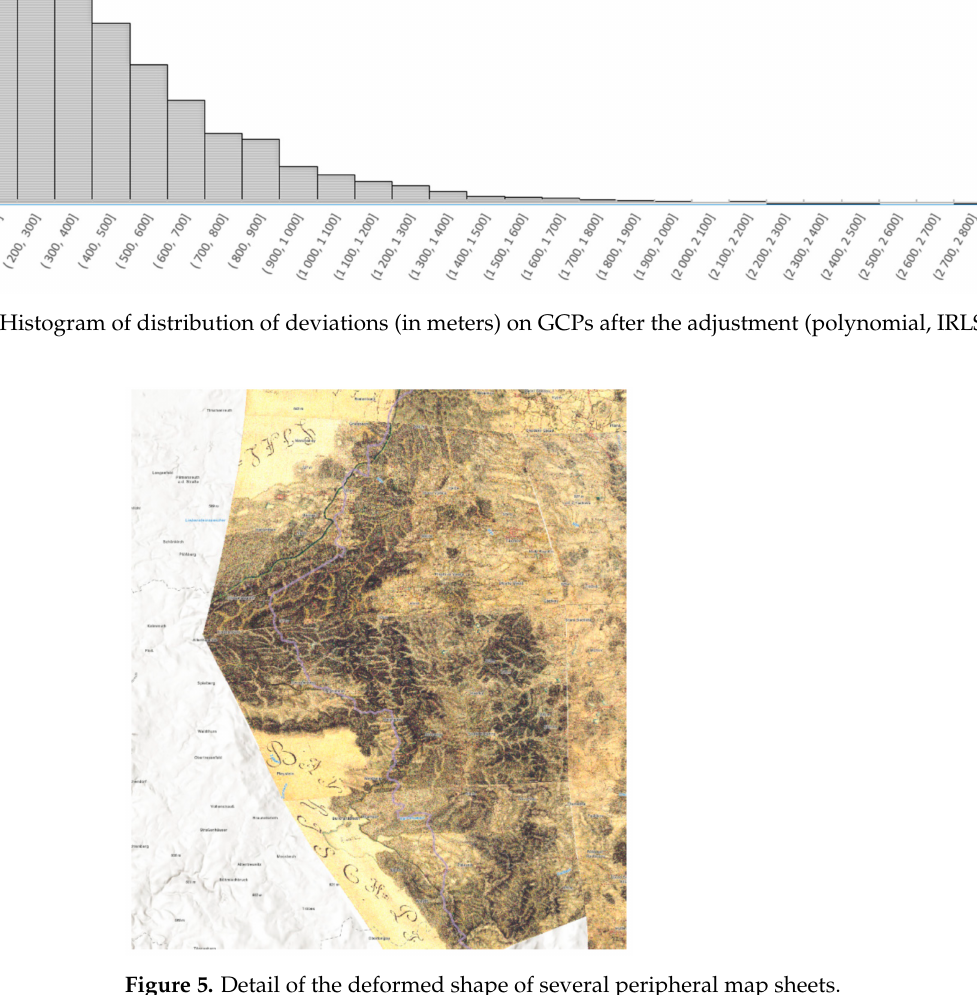
Figure 5. Detail of the deformed shape of several peripheral map